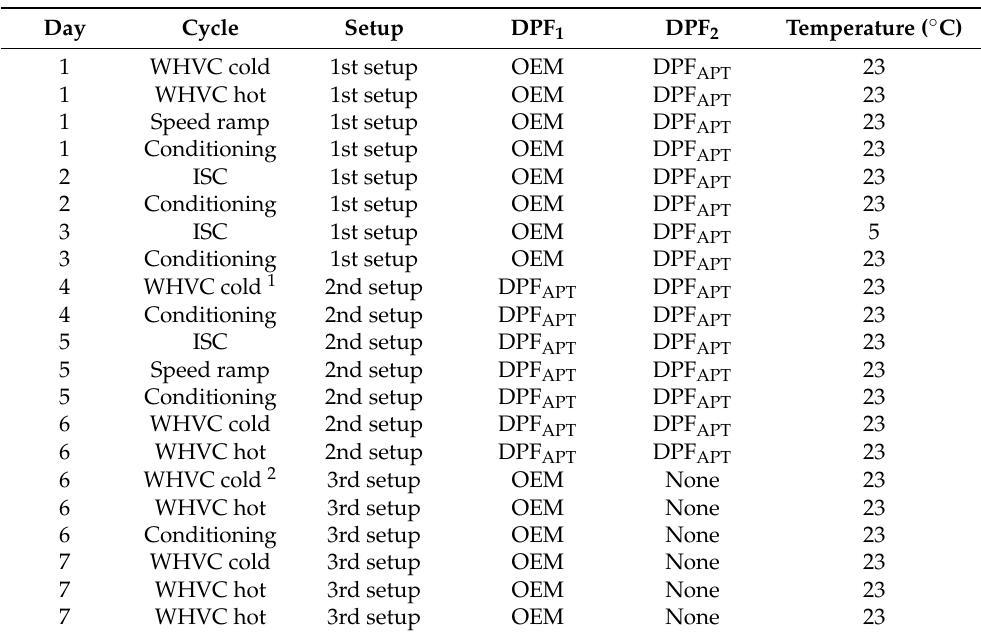
Table 1. Test protocol.